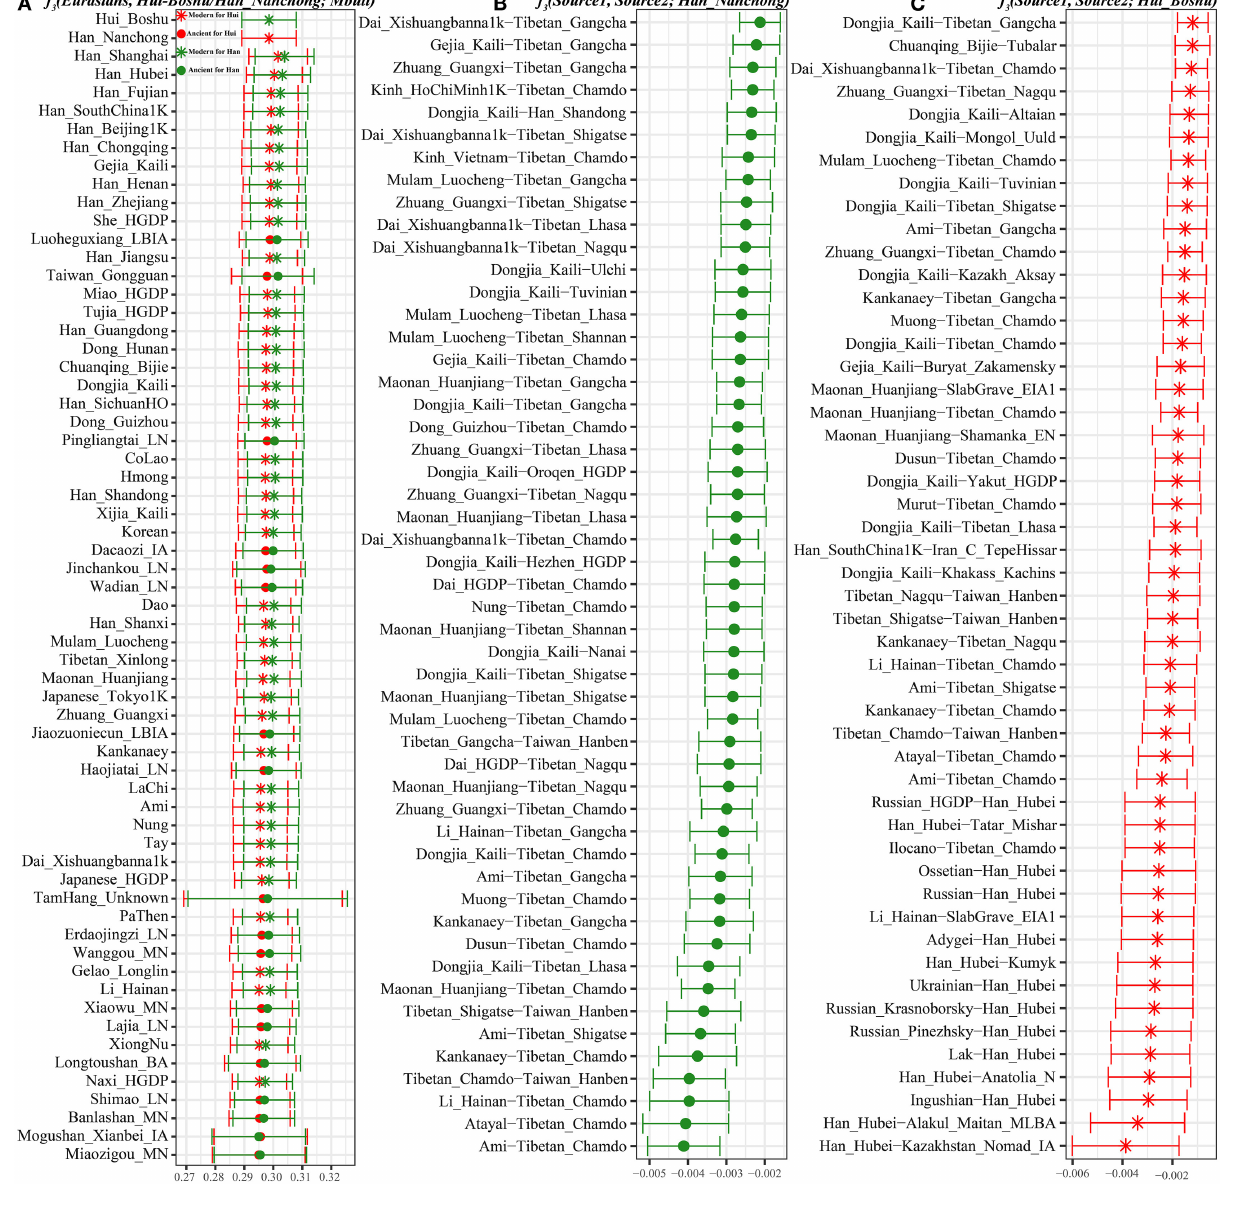
suggesting the long-term continuity of primary ancestry in the genetic transformation: Southeastern Neolithic-to-Historic people clustered with modern Austronesians; late-Neolithic-to- Historic Southeast Asians grouped with modern Austroasiatic and Tai-Kadai; ancient Nepal Tibetans clustered with modern highland Tibeto-Burman speakers; Northern East Asians from the Yellow River basin grouped with modern Sinitic people; Siberian ancients mainly clustered with modern Mongolic,